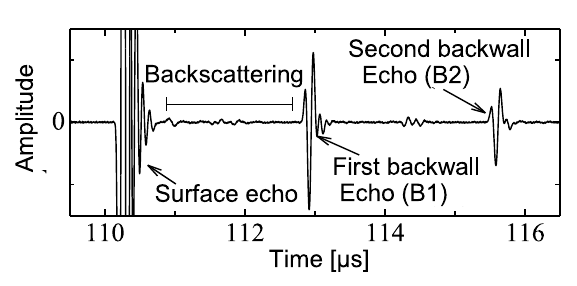
Figure 3. The typical waveform recorded using the ultrasonic mea- surement. The obtained data spanning from surface echo to second backwall echo (B2) were used for analyzing the ultrasonic variables.